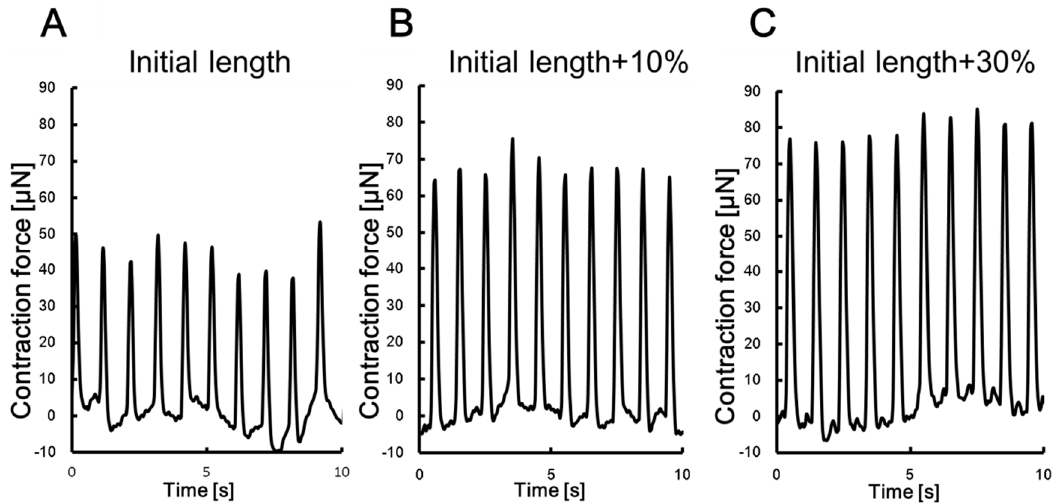
Figure 2. Results obtained by the contractile force measurement method for three tension conditions: ( A ) Initial length, ( B ) initial length + 10%, and ( C ) initial length + 30%. The respective average contractile forces were approximately 42.7, 66.8, and 79.6 μ N.